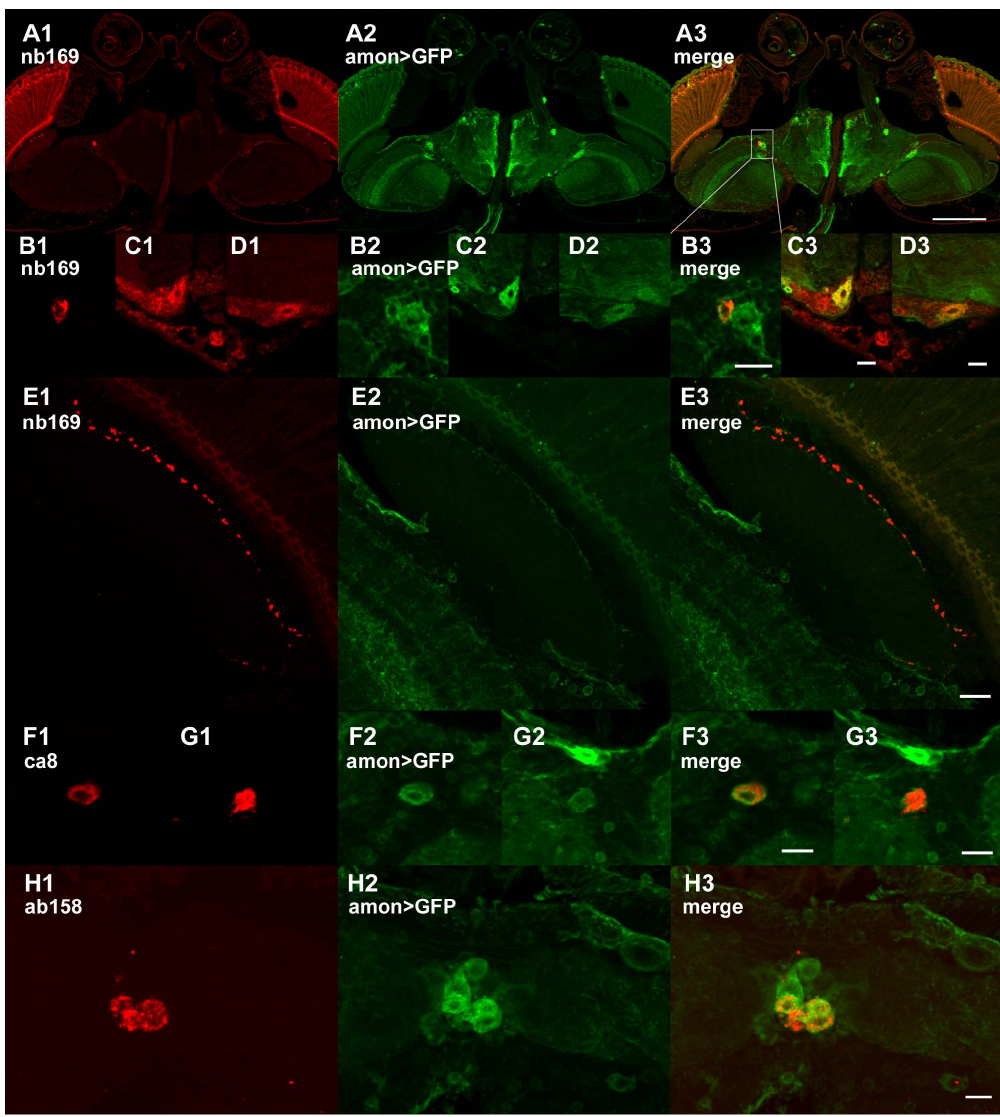
Figure 6. The antigens detected by mAbs nb169, ca8, and ab158 may be related to neuropeptides. (A-E) The cell stained by nb169 (red) (A, enlarged in B), and the giant cells in the caudal protocerebrum (C and D from different sections) all are positive for GFP (green) expressed under the control of 386Y amon-Gal4 which has been shown to selectively mark neuropeptide-containing cells. (E) The neurite of a 386Y amon -Gal4 . GFP- positive cell at the boundary between lamina cortex and neuropil apparently contains in discrete varicosities the nb169 antigen. (F,G) Examples are shown for co-localization of 386Y amon -Gal4-driven GFP and ca8 antigen in cells of the lateral protocerebrum. (H) Cells containing ab158 antigen in the pars intercerebralis, a region containing many neurosecretory cells, are also positive for amon-Gal4-driven GFP. Scale bar in A: 50 m m; in